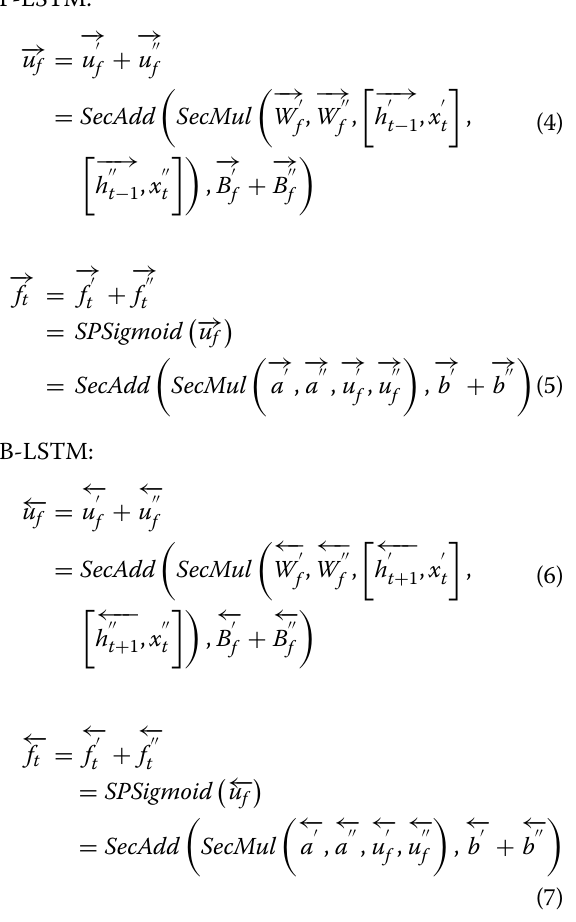
(cid:5)(cid:5) (cid:5)(cid:5) and b